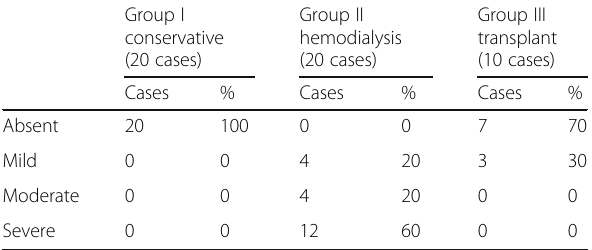
Table 4 Frequency of different grades of thrombosis among three